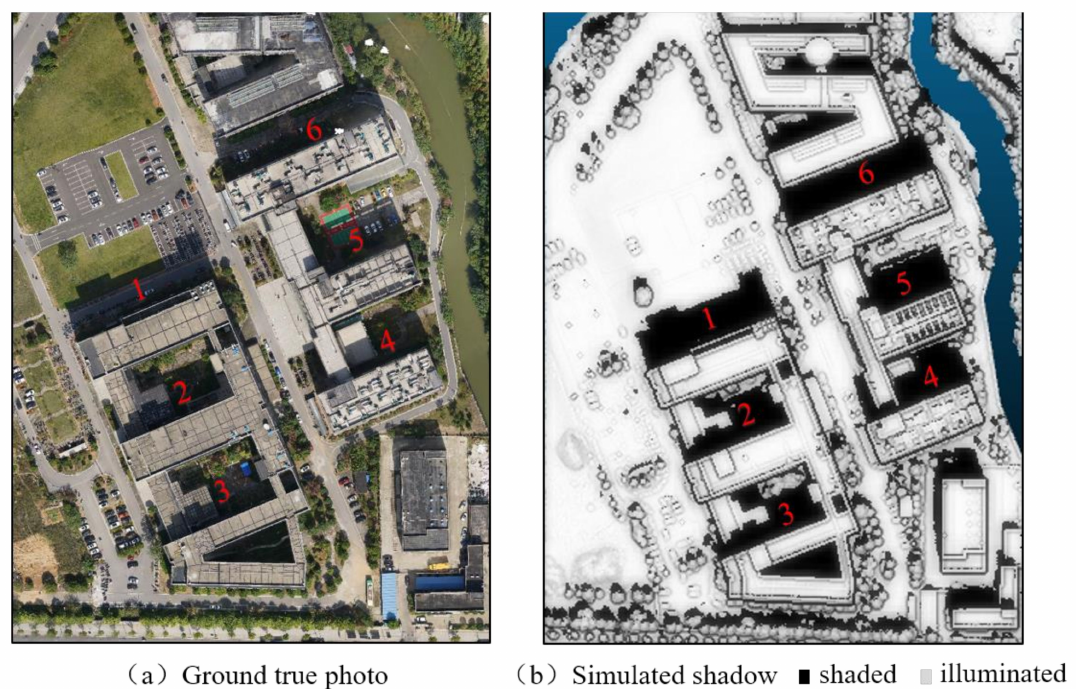
Figure 11. Shadow simulation against orthoimage (time: 11:25 on 31 October